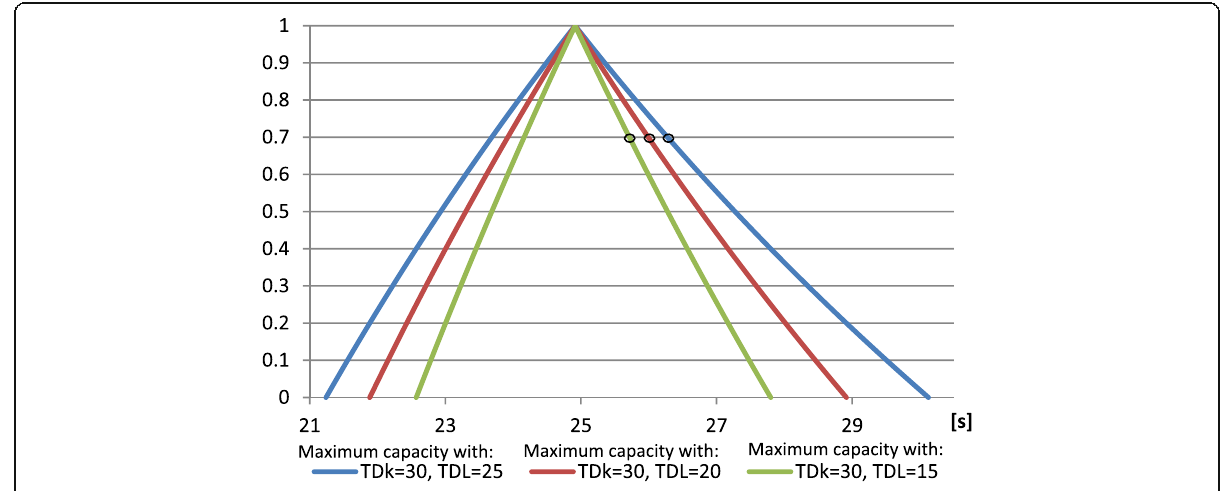
Fig. 13 Influence of T DL support variation on Fuzzy Maximum Capacity and C ope (Possibility = 0.7, Necessity=